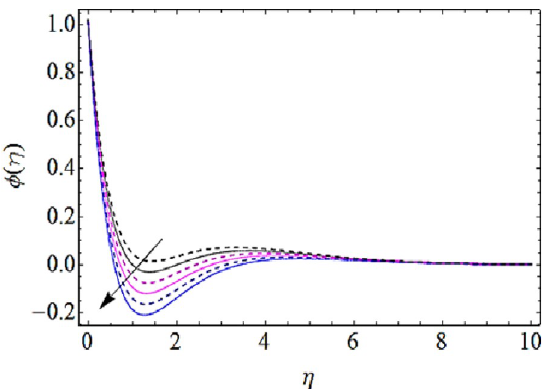
Fig 15. Concentration characteristics for various values of chemical reaction